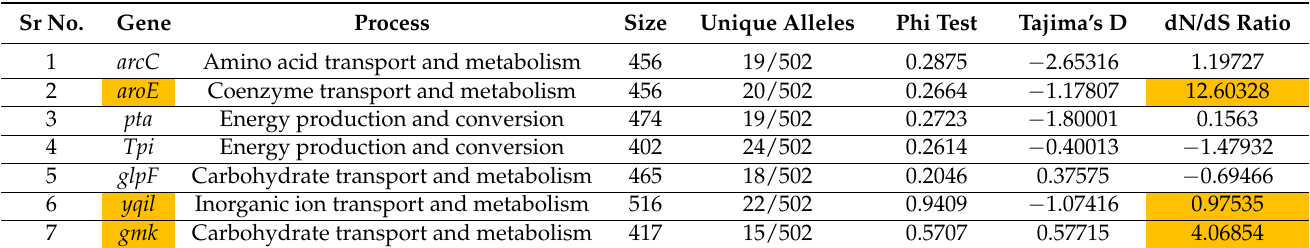
Table 3. Current MLST scheme. The orange regions in the table indicate genes having unsuitable statistical values.